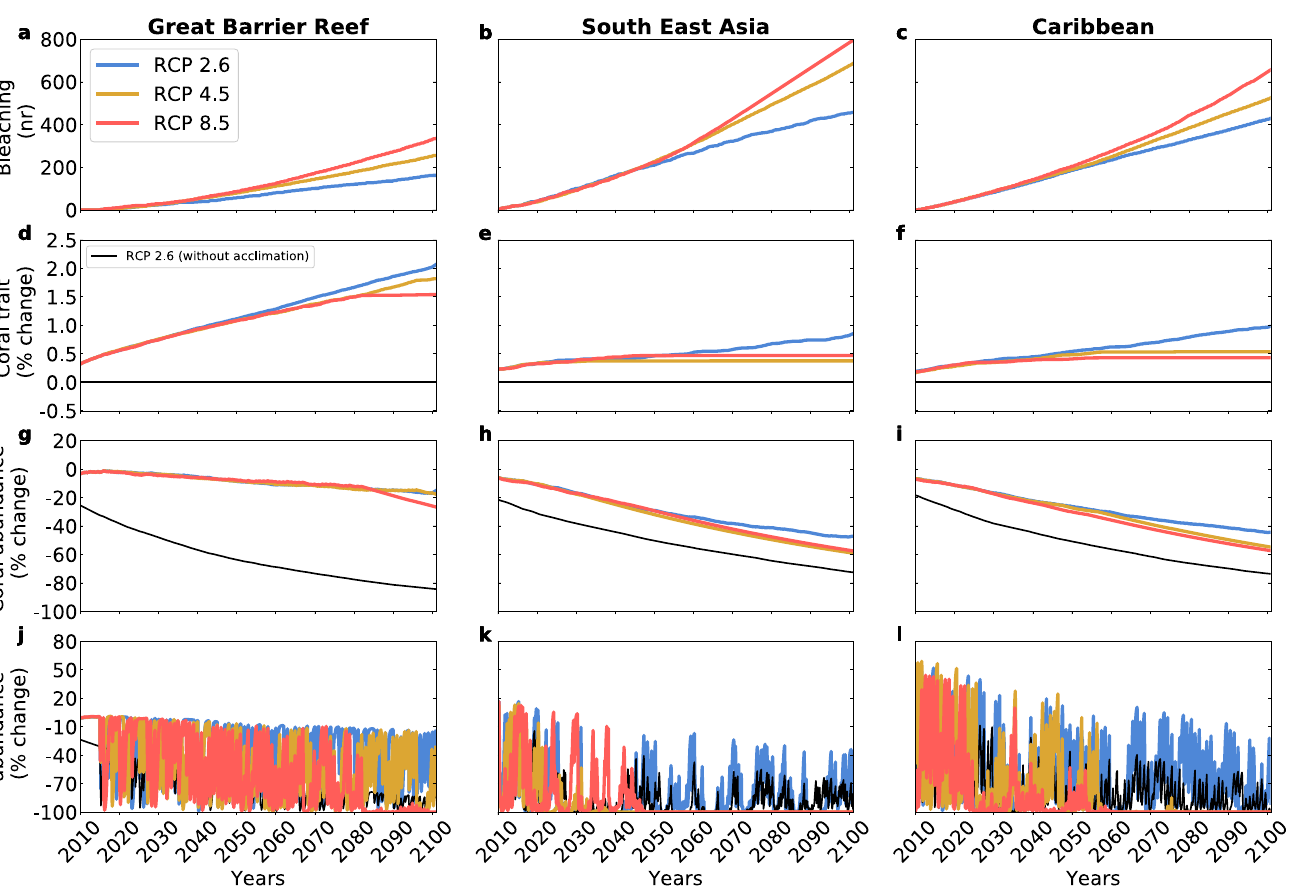
Fig 3. Simulated trait and abundance dynamics in the three regions and under different RCPs. (a - c) Cumulative number of bleaching assuming that these events occur whenever environmental temperature exceeds by 2˚C the optimal temperature for coral growth. (d - f) Coral energy investment trait. (g - i) Coral abundance and (j - l) symbiont abundance, relative to the period 1986–2005. Note that in South East Asia and in the Caribbean, the dynamics of coral trait and coral abundance under RCP 4.5 overlap with those under RCP 8.5. In the year 2010, the coloured lines and the black lines are at different levels because, in the runs with acclimation (coloured lines), corals are able to reach higher abundances during the spin-up phase and between 1955 and 2010, thus increasing the overall performance of the coral-algae